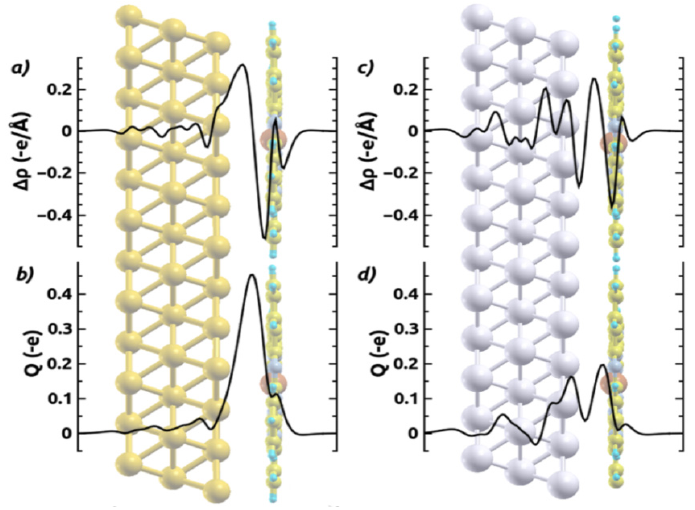
Figure 5. Plane-integrated charge rearrangements ∆ ρ ( z ) (top plots; ( a ) and ( c )), and cumulative charge transfer Q ( z ) (bottom plots; ( b ) and ( d )) for the adsorption of CuPc on Au(111) (left plots; ( a ) and ( b )) and on Ag(111) (right plots ( c ) and ( d )) calculated using the HSE06 functional. Positive (negative) values in ∆(cid:2025)( z ) plots correspond to an accumulation (reduction) of electron density. Q ( z ) indicates, how many electrons per unit cell have been transferred from right to left of a plane at position z. − e, here denotes the negative elementary